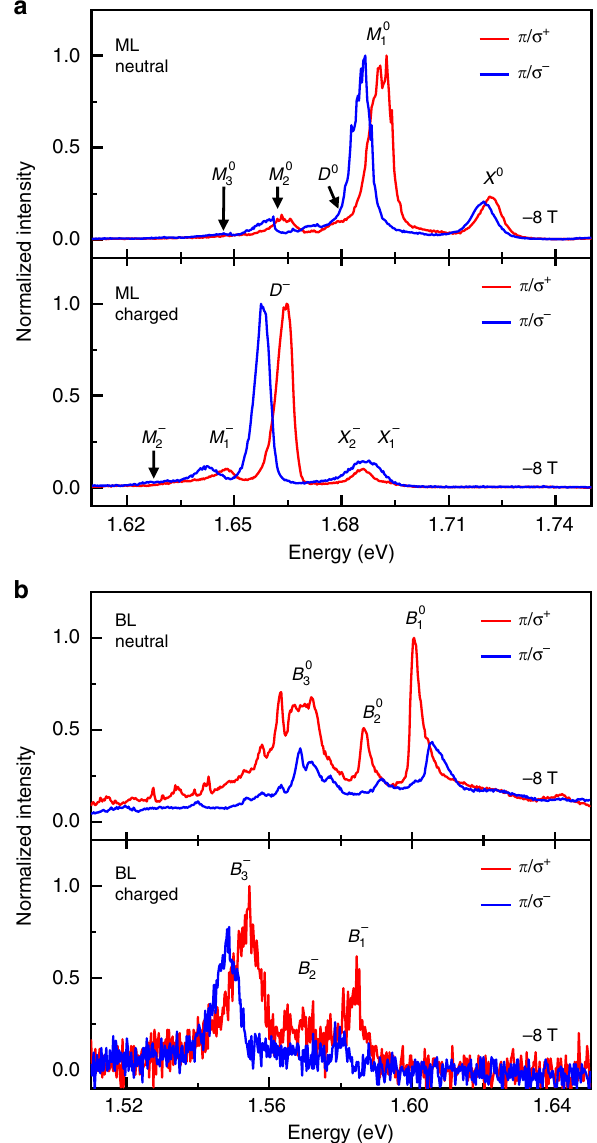
Fig. 2 Magneto-luminescence spectroscopy of charge-controlled monolayer and bilayer WSe 2 . a , b Photoluminescence spectra of monolayer and bilayer WSe 2 , respectively, in a perpendicular magnetic fi eld of − 8 T. The neutral and negatively charged regimes are shown in the top and bottom panels, respectively. The spectra were recorded with linearly polarized excitation ( π ) and circularly polarized detection ( σ + and σ −